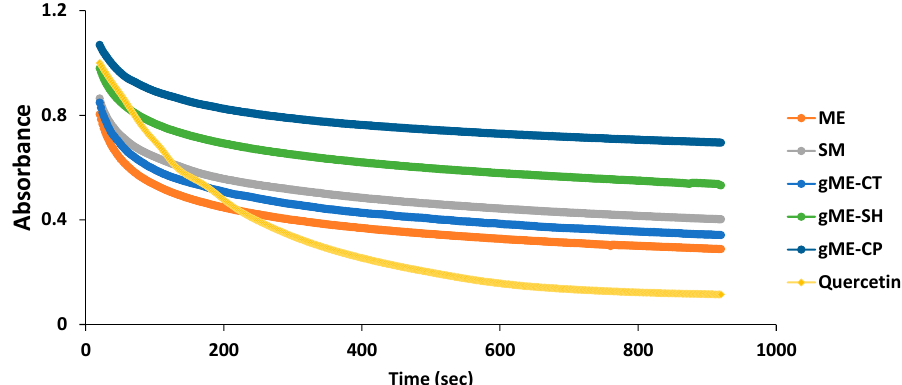
Figure 3. Evolution of the DPPH solution absorbance for CURC encapsulated in various microemulsion systems and reference solvent mixtures (sample denoted in Table 1).